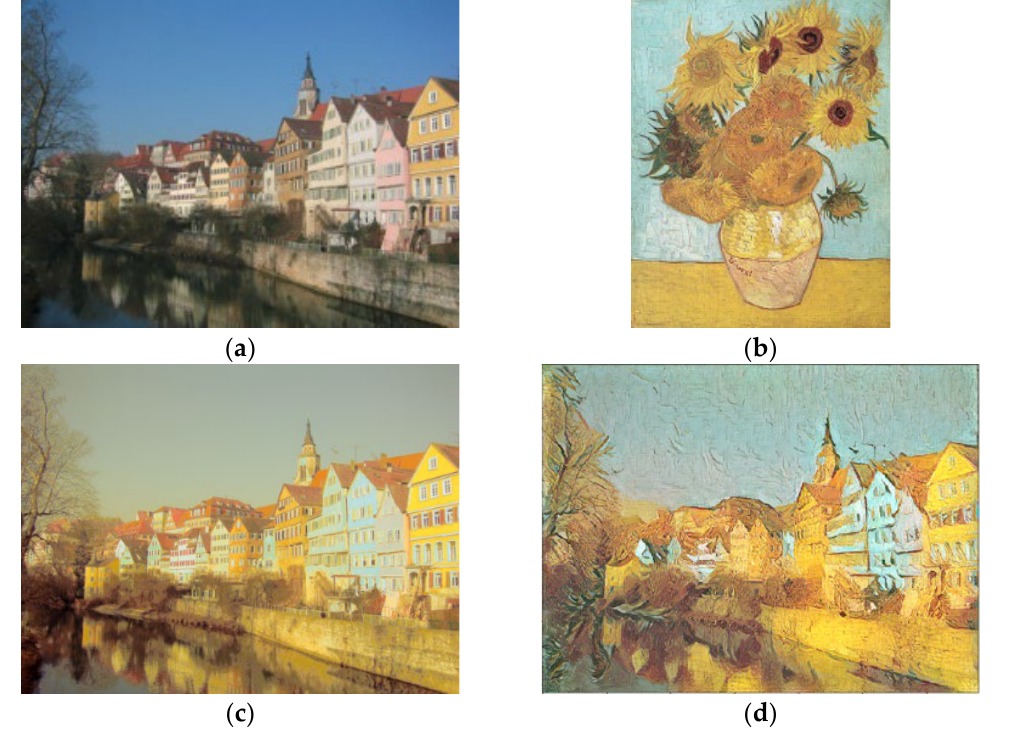
Figure 12. The results of the proposed method image transfer between the landscape image and impressionist image. ( a ) Content image. ( b ) Target image. ( c ) Our color-transferred image. ( d ) Our style-transferred image.